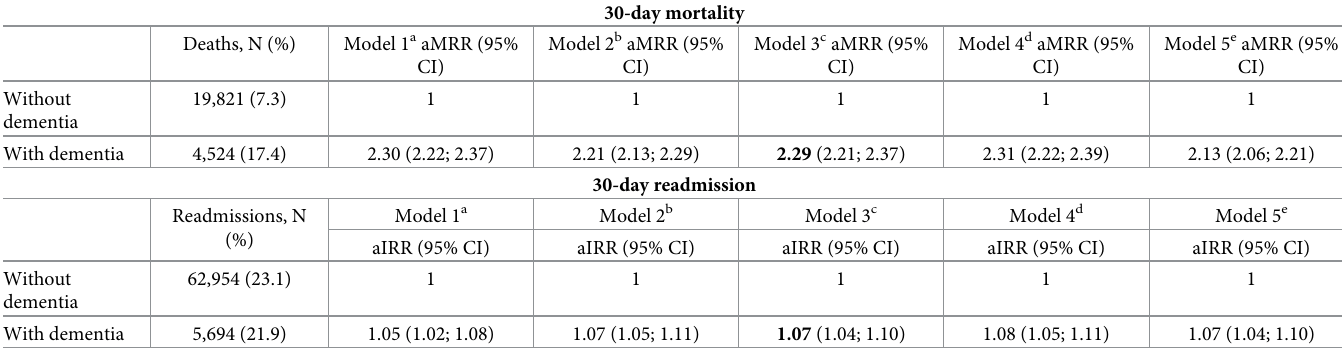
Table 2. Stepwise adjusted mortality rate ratios (aMRRs) for the risk of 30-day mortality and stepwise adjusted incidence rate ratios (aIRRs) for the risk of 30-day readmission in pneumonia patients with dementia (N = 25,948) versus those without (N = 272,924) in 298,872